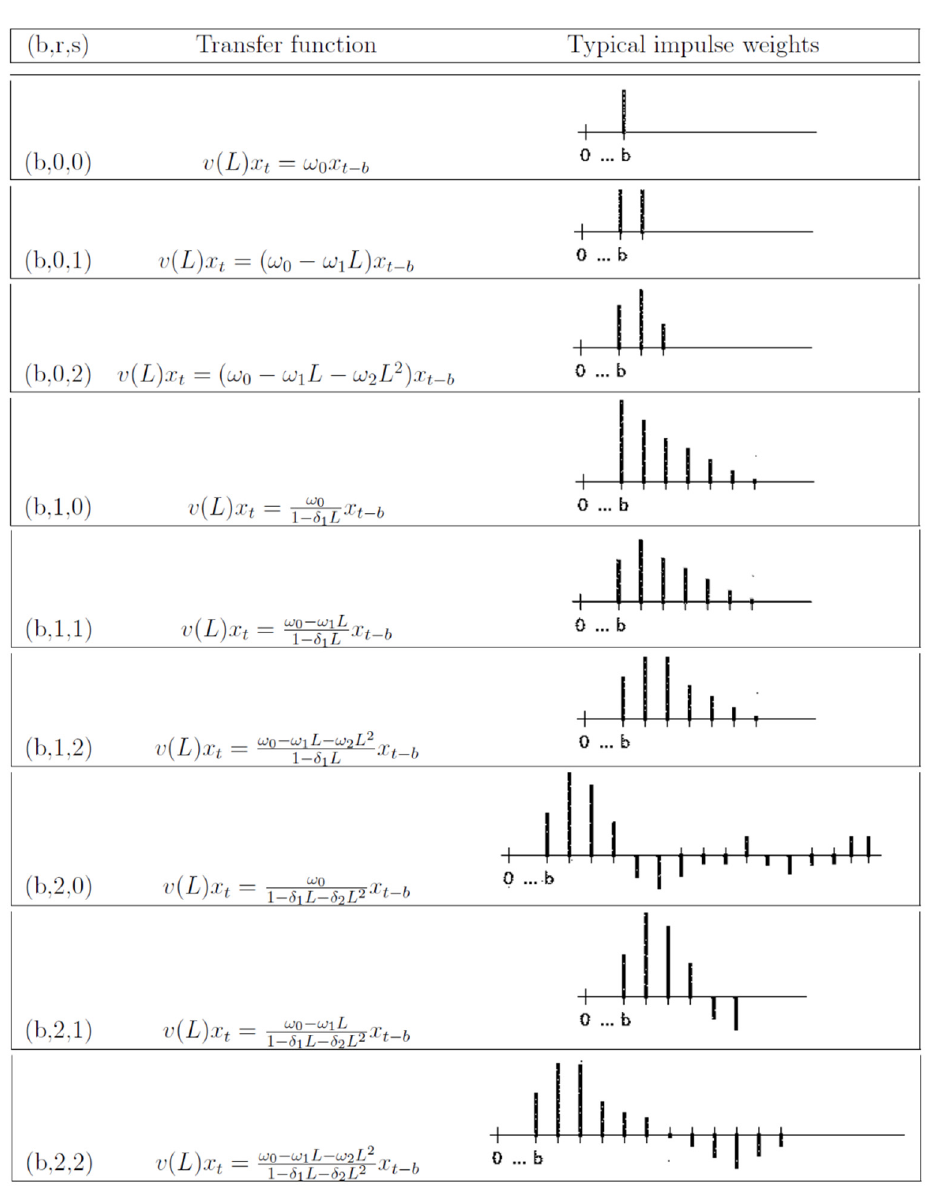
Figure A1. Resource: Galeano (2015).